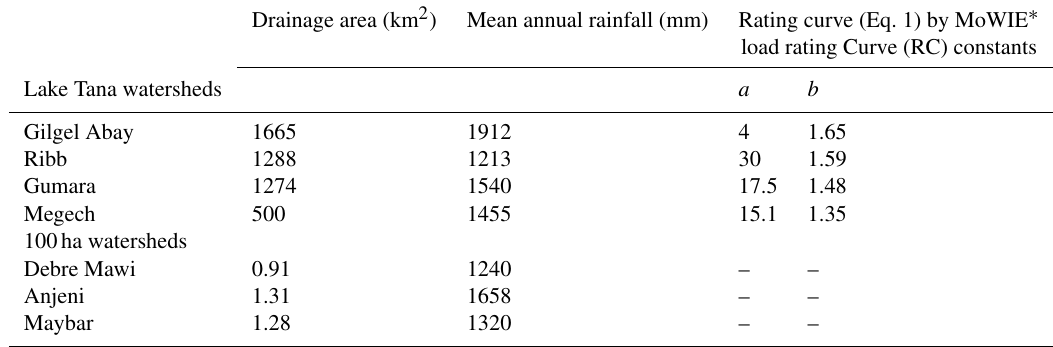
Table 1. Characteristics of the study watersheds in the Lake Tana Basin and the three 100 ha watersheds in the Ethiopian